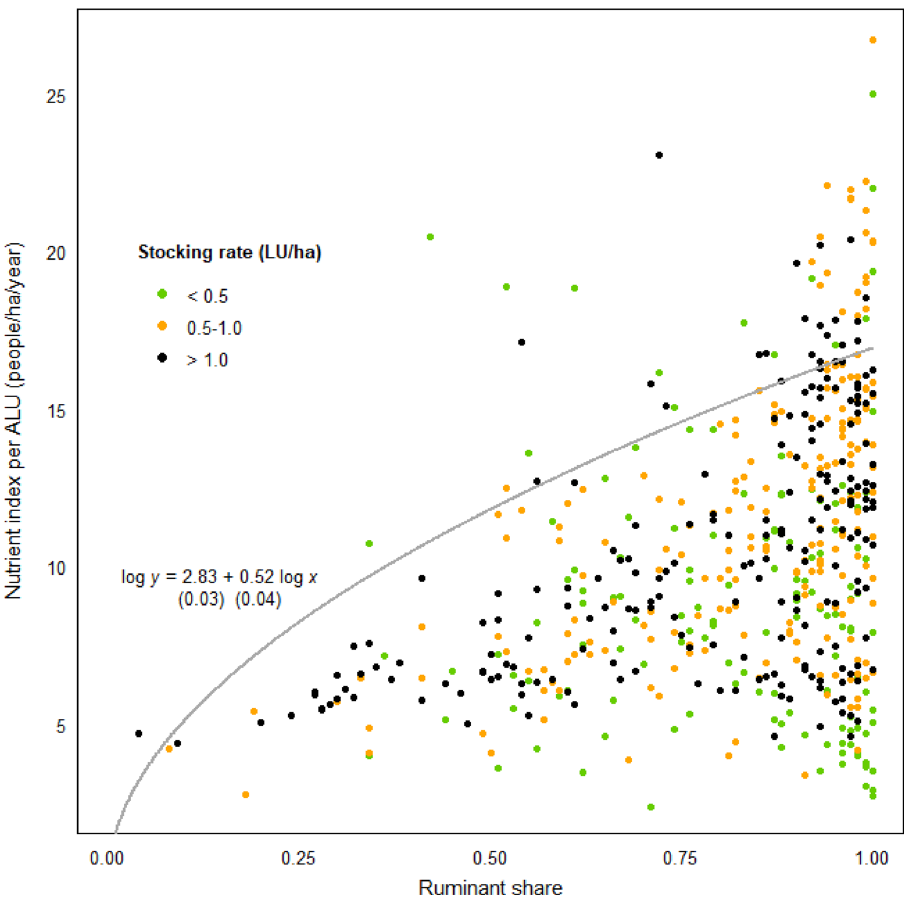
Figure 2. Relationship between the share of ruminants in a subregion’s livestock population and nutrient provision capacity per arable land use (ALU) in France. Each datapoint represents a single agricultural subregion ( petites régions agricoles ), colour-coded by stocking rate. The positive slope of the production frontier function suggests that the greater the ruminant share, the higher the subregion’s potential to provide essential nutrients from a given area of arable